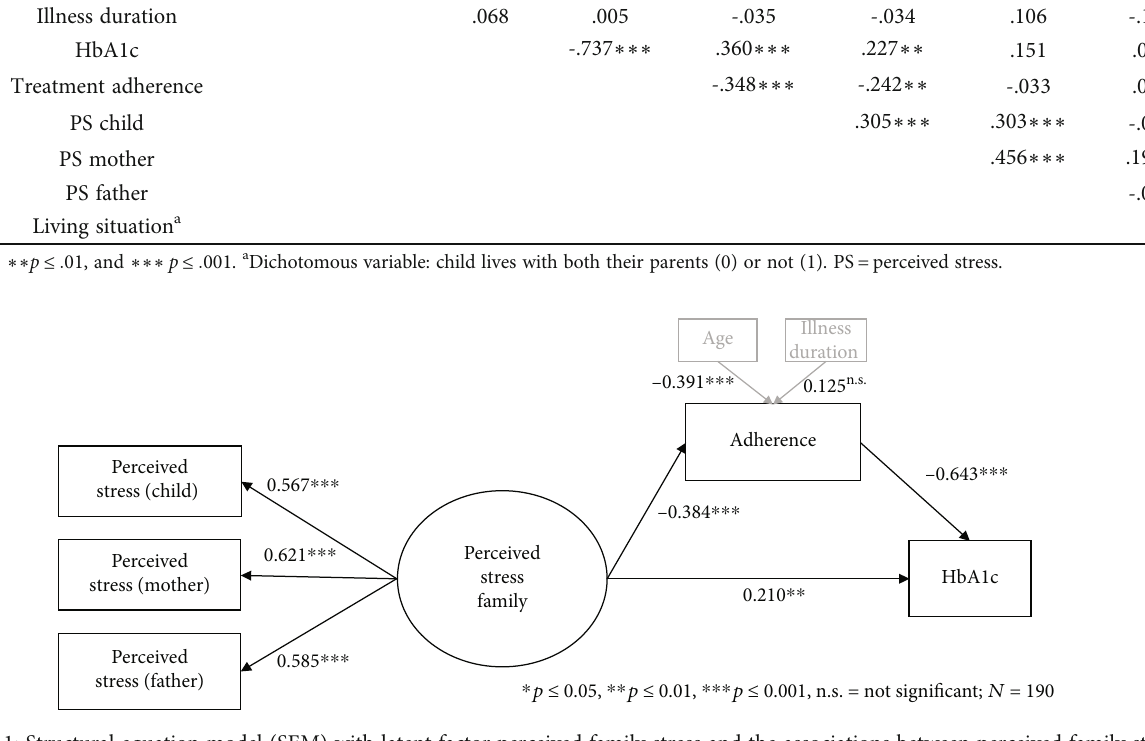
Figure 1: Structural equation model (SEM) with latent factor perceived family stress and the associations between perceived family stress and patients ’ treatment adherence, perceived family stress, and patients ’ glycated hemoglobin (HbA1c), patients ’ treatment adherence, and patients ’ HbA1c were calculated. To control for patients ’ age and illness duration, their association with patients ’ treatment adherence were also computed. All coe ffi cients are